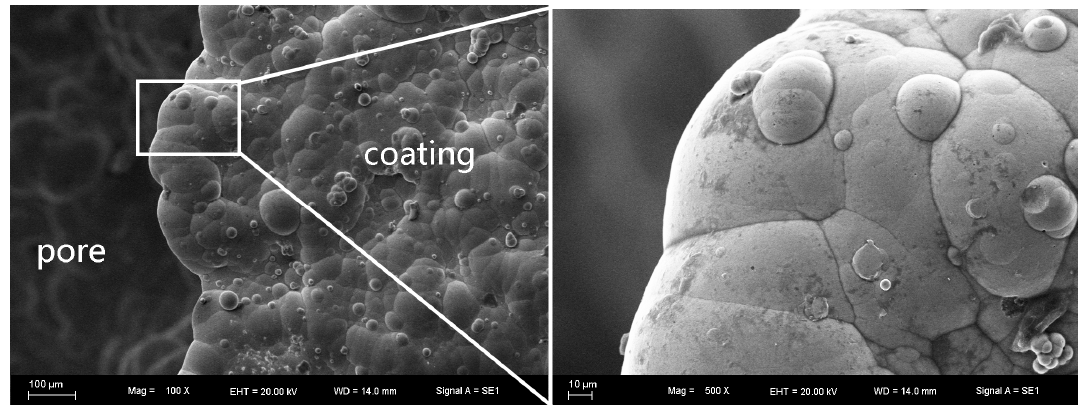
Figure 3. The surface topographies of electroless Ni–P (EN) coating.